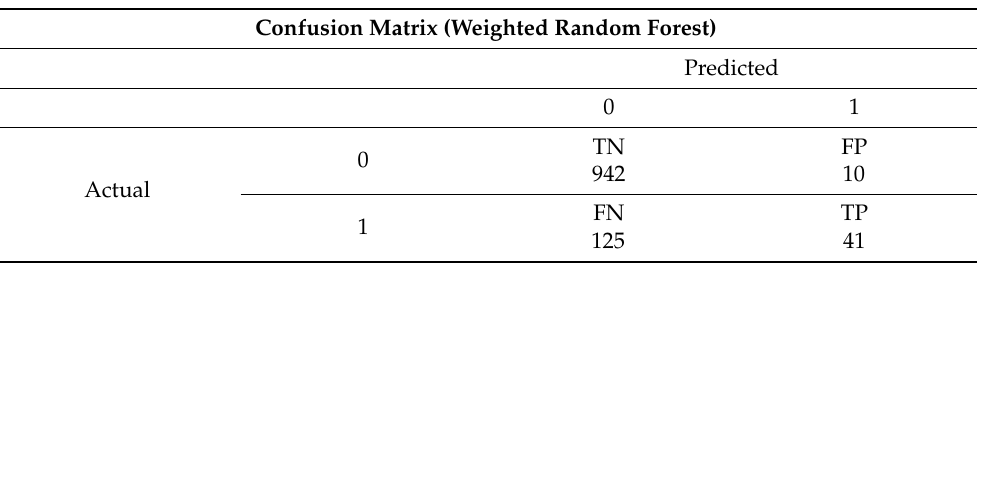
Table 8. Confusion matrix of weighted random forest